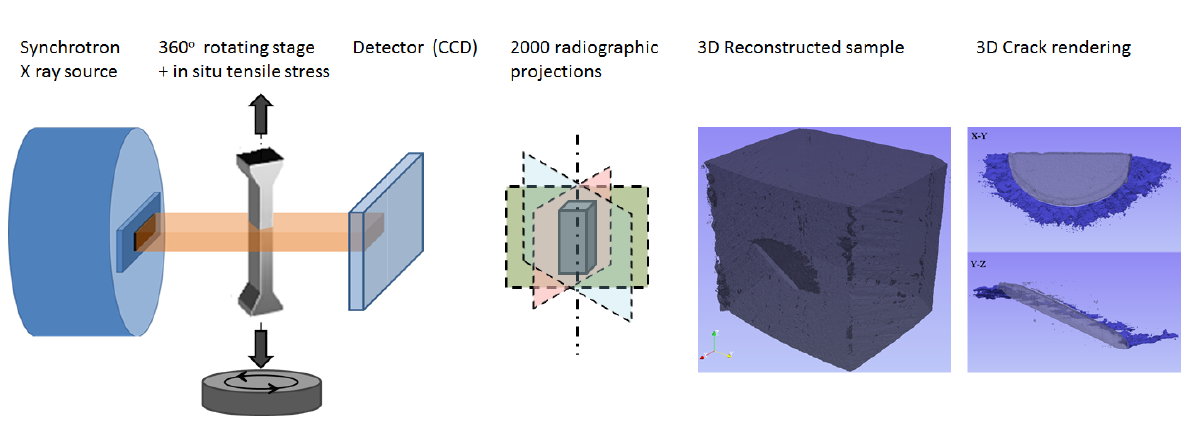
Figure 2: Schematic view of the tomographic acquisition process, volume reconstruction and 3D crack